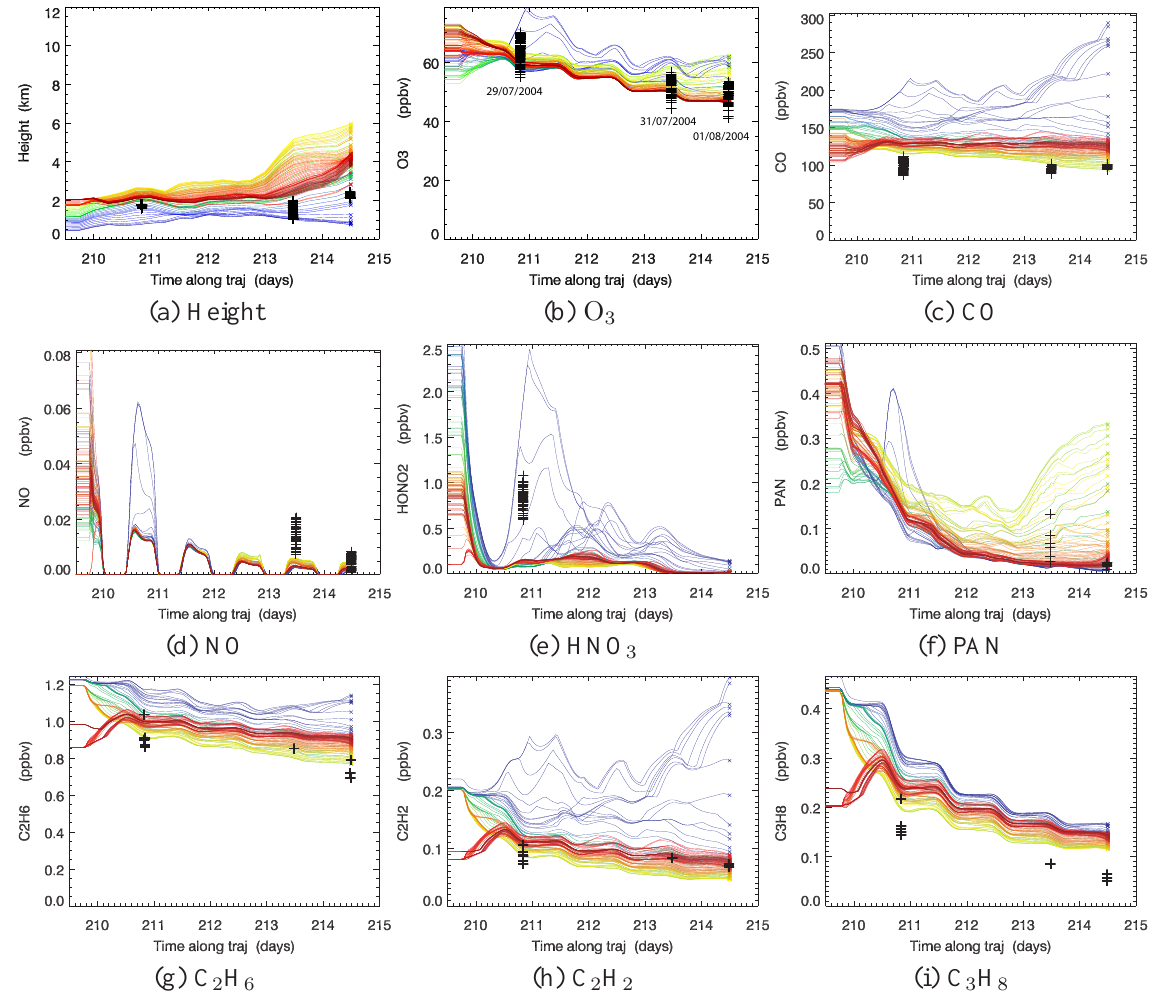
Fig. 4. Case 5 ensemble of trajectories for the control simulation. Trajectories are coloured by their release time from the flight track on Fig. 4. Case5ensembleoftrajectoriesforcontrolsimulation. Trajectoriesarecolouredbytheirrelease 27 July 2004 so that individual trajectories can be distinguished. Blue trajectories remain lower in altitude than the main plume for the time from the flight track on 27 July 2004 so that individual trajectories can be distinguished. Blue duration of this case. Other details as in Fig. trajectoriesremainlowerinaltitudethanthemainplumeforthedurationofthiscase.Otherdetailsasin 47 Fig.1.